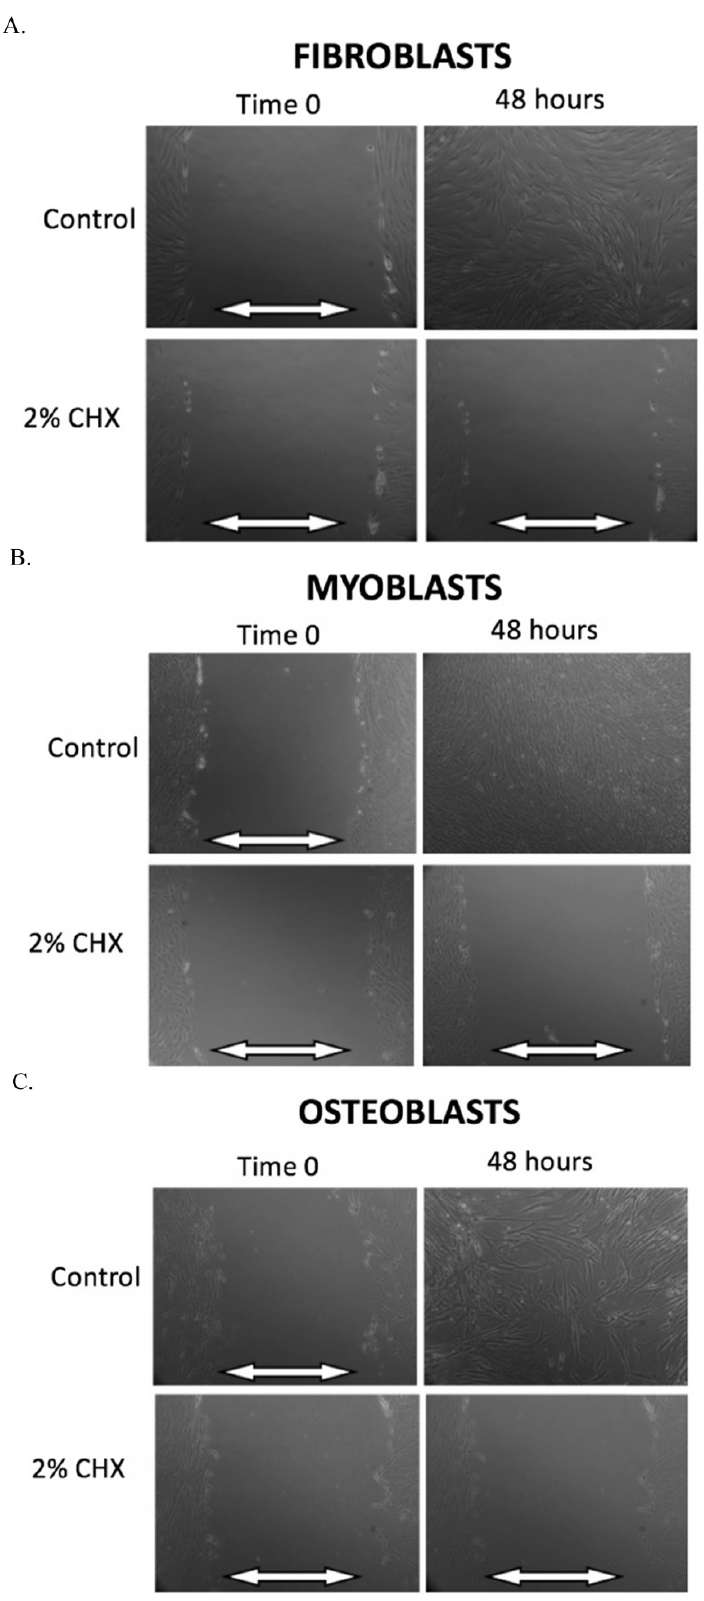
Figure 2. A-C. Scratch test results. At Time 0, scratch defects were initiated in monolayer cell cultures and exposed to either control conditions or the clinically used concentration of 2% CHX for 3 minutes. 48 hours later, photos were taken of the scratch defects to observe defect closure. White arrows demonstrate the width of scratch defect. Closure of the scratch defect is seen at 48 hours following exposure to control conditions for all cell types. Open scratch defects are seen at 48 hours following exposure to 2% CHX for 3 minutes. A) Fibroblasts, B) Myoblasts, C)